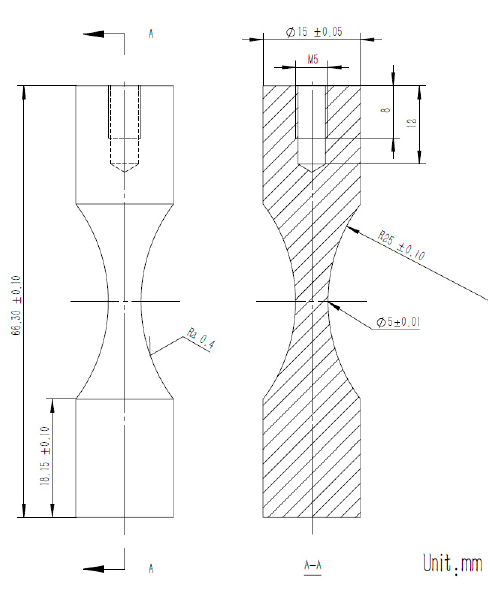
Figure 5. Specific geometry of Inconel 718 specimen tested at 20 kHz.